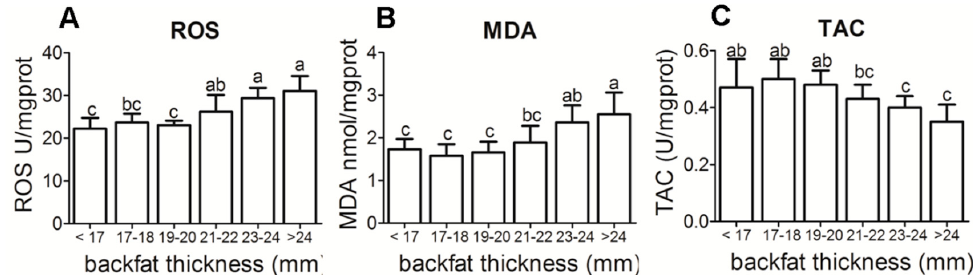
Figure 1. Antioxidant status in placenta of different backfat thickness sows. ( A ) Placental reactive ROS level in different backfat thickness sows; ( B ) Placental reactive MDA level in different backfat thickness sows; ( C ) Placental reactive TAC level in different backfat thickness sows. ROS—reactive oxygen species; MDA—malondialdehyde; TAC—total antioxidant capacity. Each group had 10–12 sows, 4–5 placenta samples were analyzed per sow, mean ± SEM. Different letter showed significant difference ( p < 0.05).